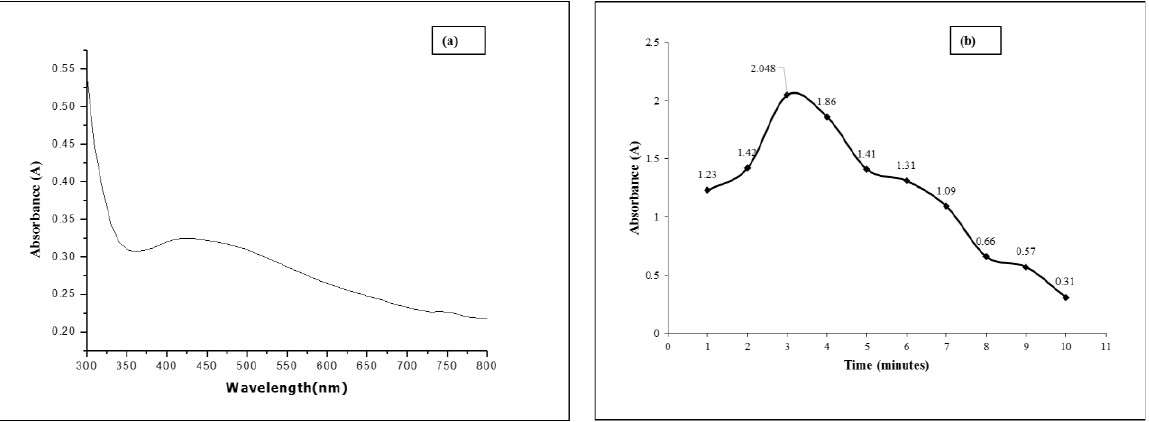
Figure 2. ( a ) The surface plasmon absorbance spectrum of the 20 nm AgNPs produced using the optimized conditions: ( b ) Effect of exposure time on the synthesis of nanoparticles using microwave (MW) irradiation determined at 425 nm.